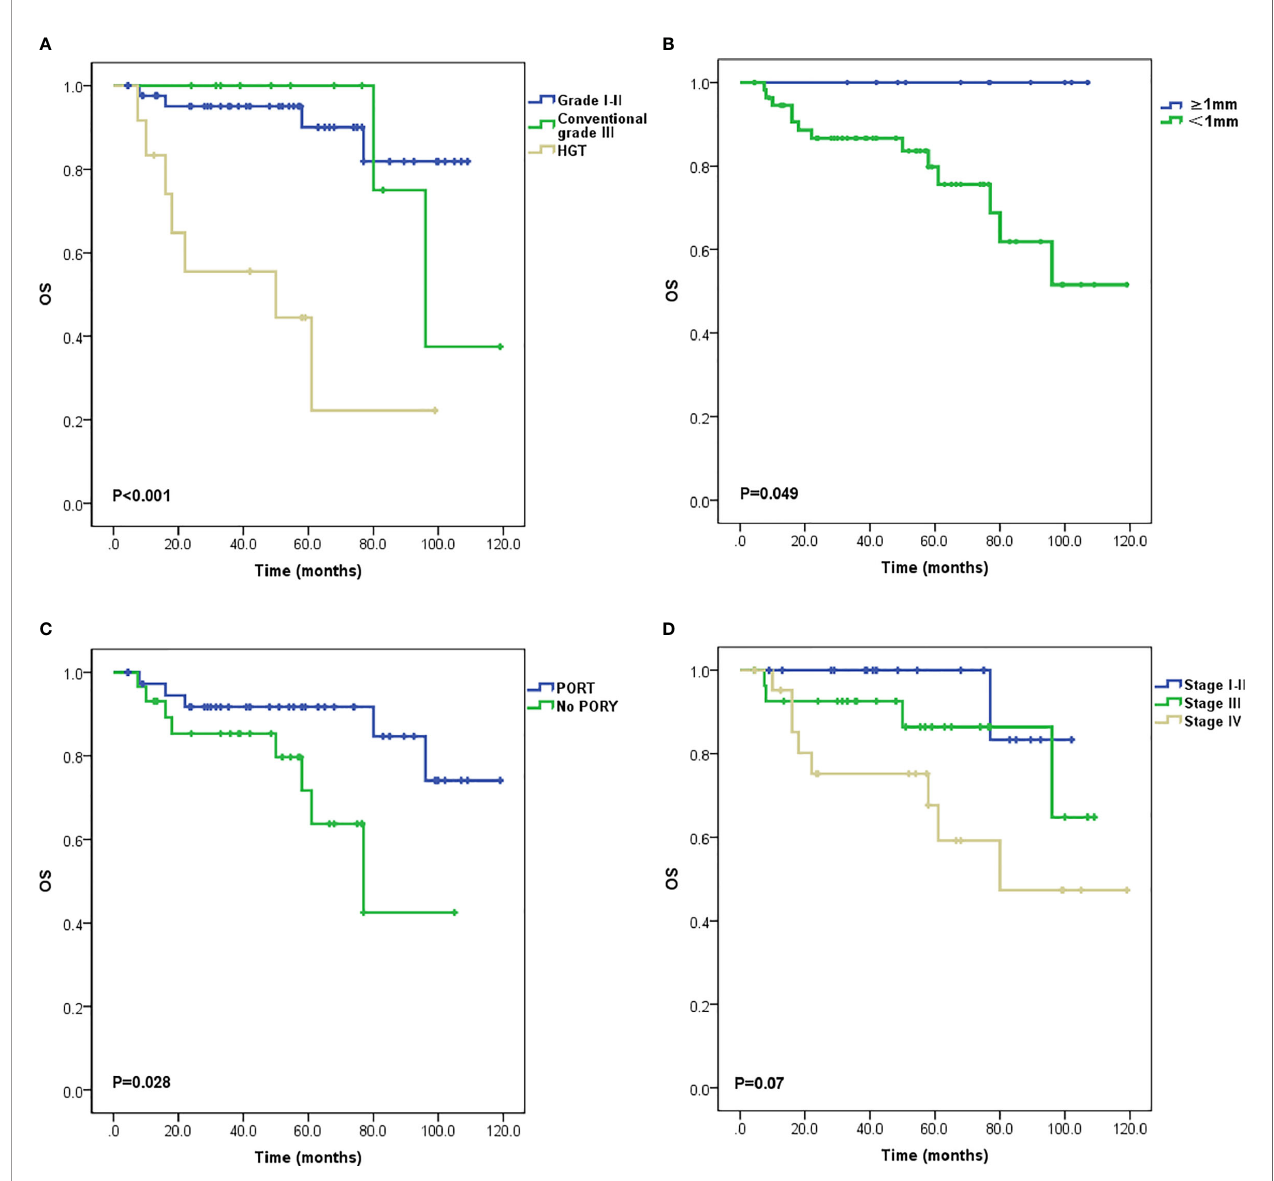
FIGURE 3 | Survival curves for overall survival (OS) (A) Tumor grading, (B) Margin status, (C) Postoperative radiotherapy (PORT) and (D) Stage